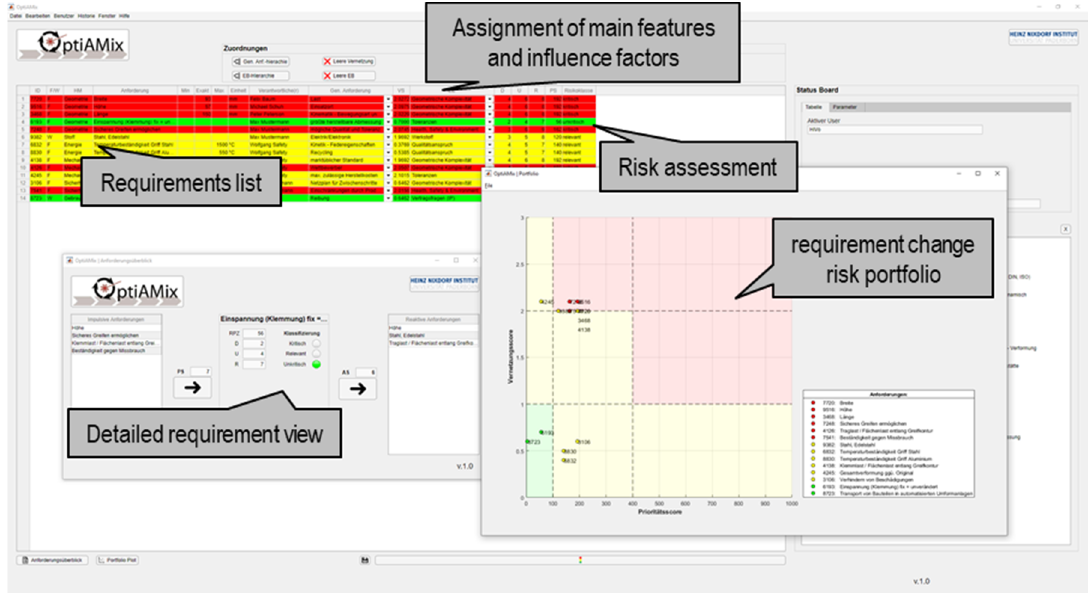
Figure 10. Software prototype for semi-automated application of the method for systematic assessment of requirement change risk.